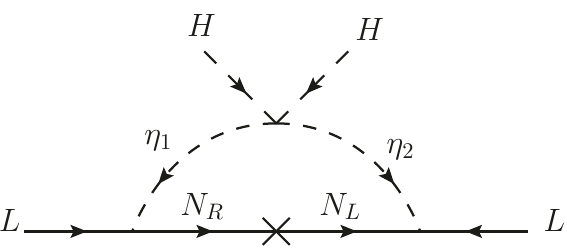
Figure 1 . Sketched Feynman diagram mediated by Z 2 -odd particles for the radiative neutrino